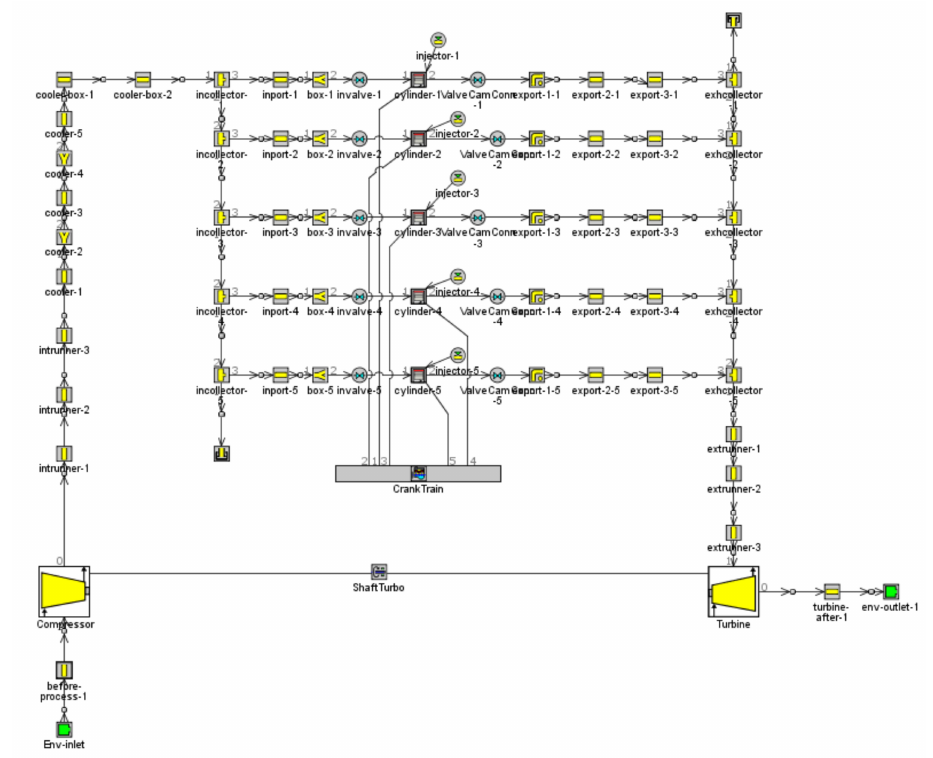
Figure 6. 1-D Model geometric structure.